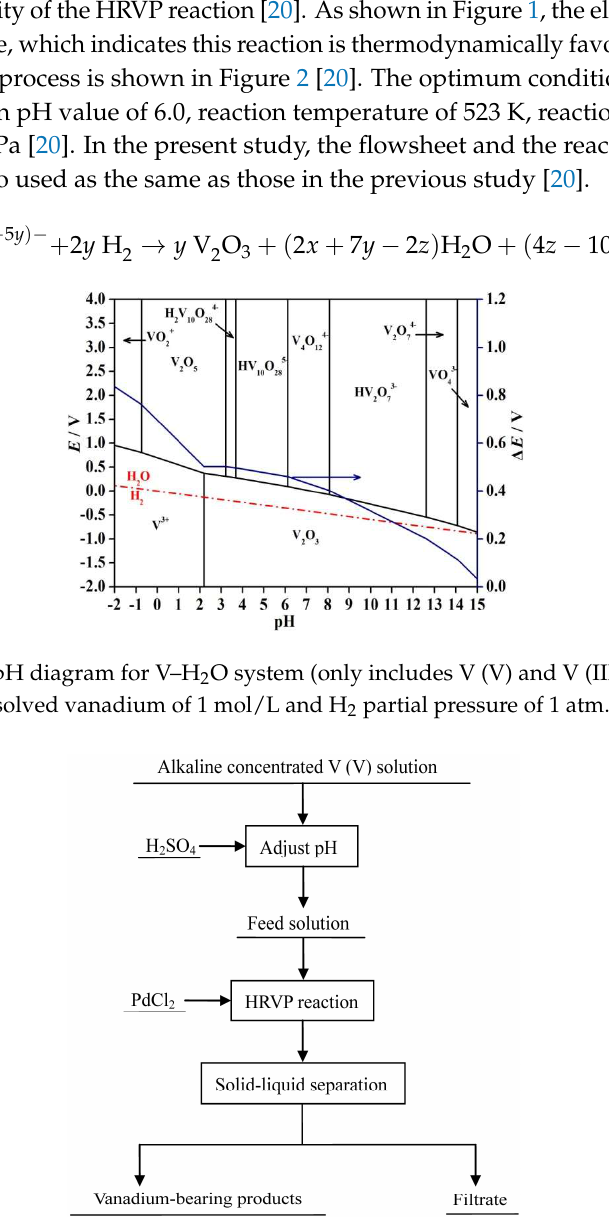
Figure 2. The hydrothermal hydrogen reduction technology (HRVP) process used in this study [20].